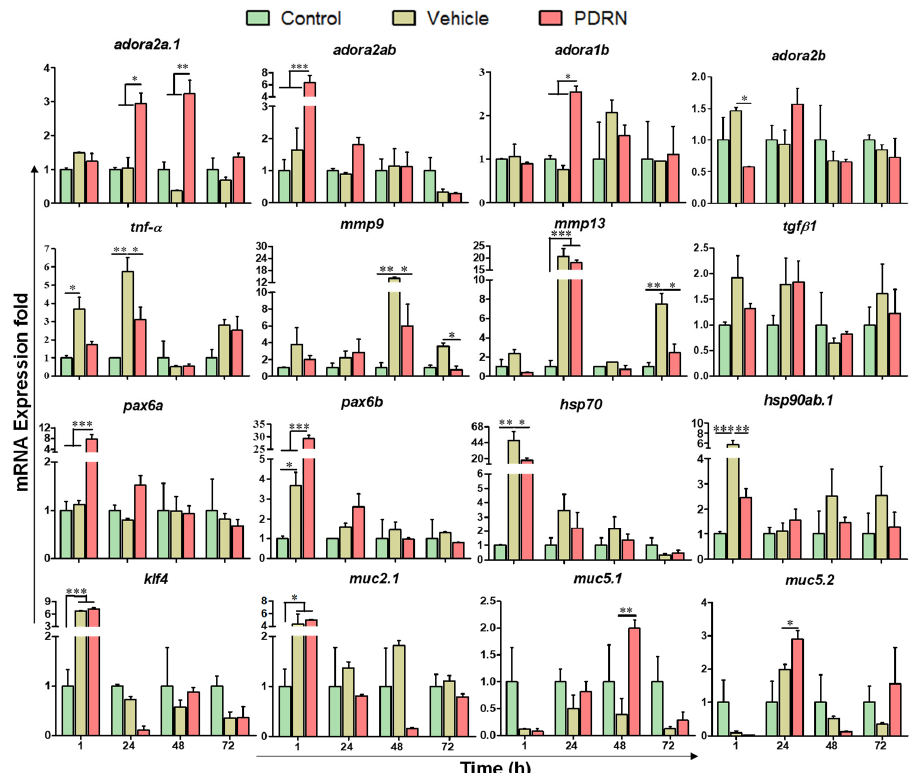
Figure 5. Transcriptional profiles of wound healing related genes in zebrafish eye upon cornea injury and PDRN treatment. The data are presented as fold changes over un-injured, cornea injury vehicle-treated, and cornea injury PDRN-treated. Three samples (R = 3) were collected from the right-side eye of nine adult fish for each condition, and two independent experiments were performed (two-way ANOVA followed by Dunnett’s post hoc test was performed to find statistical significance; * p < 0.05, ** p < 0.01, *** p < 0.001).